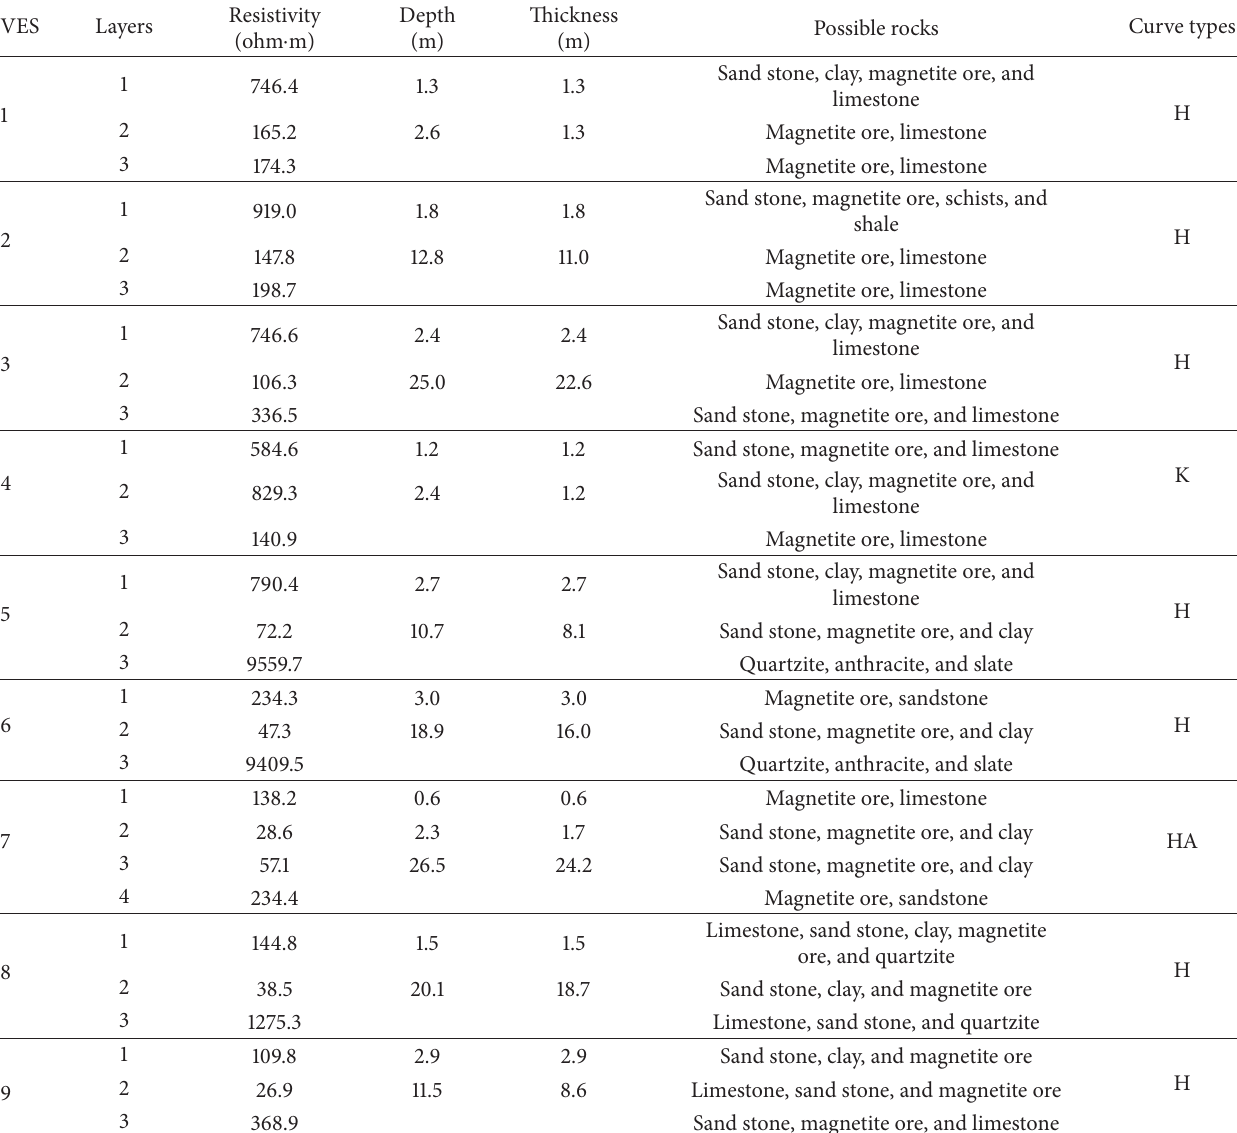
Table 3: Summary of sounding